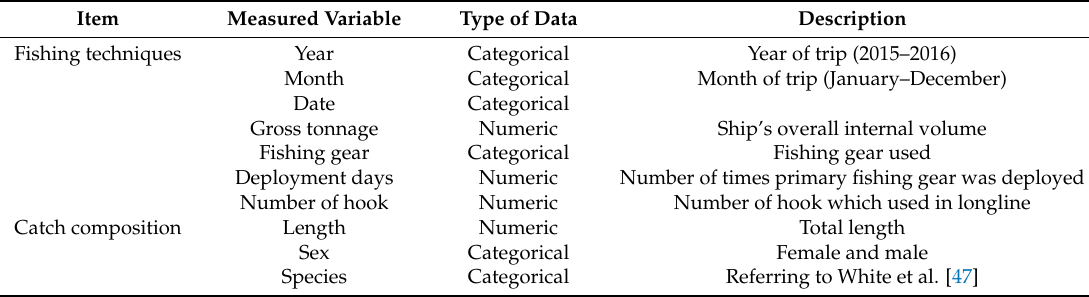
Table 2. Collected data from Cilacap and Tanjung Luar fishing